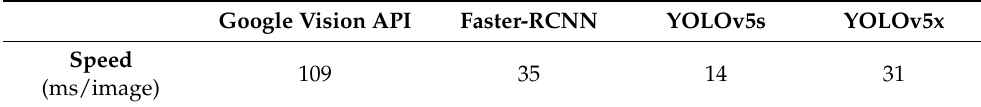
Table 4. Comparison of average processing speeds (milliseconds per image) measured for different object detection